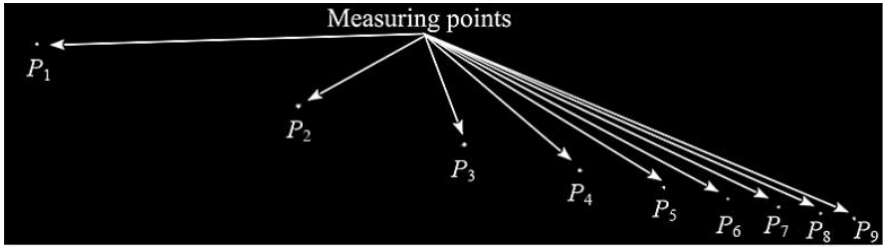
Figure 10. Tensioning construction – strain gauge for force measurement seen in the center.